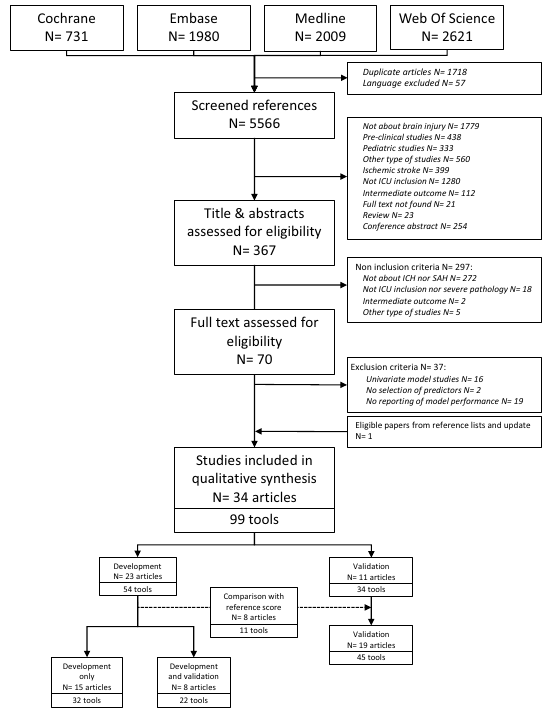
Fig. 1 Flow chart of the systematic review F‑117 RETRACT System: a computerized 3D video analyzing system for the monitoring of respiratory retraction signs in children